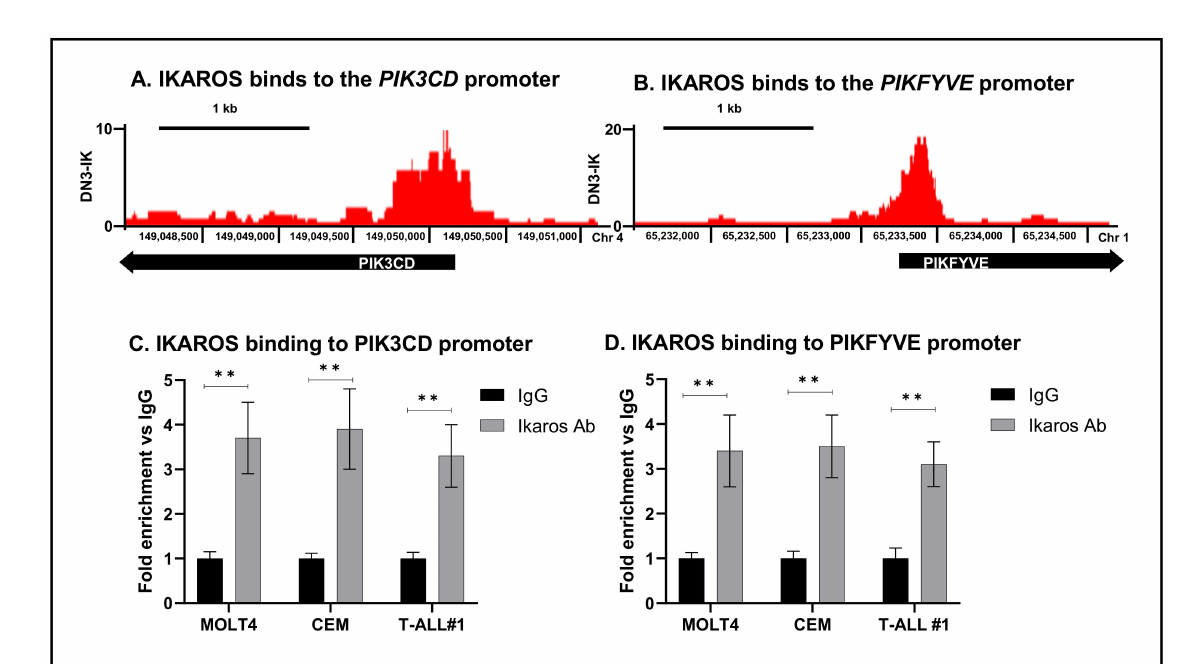
Figure 2. IKAROS binds to the promoter regions of PIK3CD and PIKFYVE . Chromatin immunoprecipitation (ChIP) followed by next-generation sequencing (ChIP-seq) and analysis of genome-wide occupancy of IKAROS was performed on DN3 cells (IKAROS-null T-ALL cells) following IKAROS re-introduction. IKAROS global DNA binding was analyzed on days 1, 2, and 3 following IKAROS introduction. ( A ) ChIP-seq signal map for IKAROS binding to the PIK3CD promoter region on day 1. ( B ) ChIP-seq signal map for IKAROS binding to the PIKFYVE promoter region on day 1. The y -axis represents a log 2 fold change enrichment of IKAROS binding (** p < 0.01). CEM, MOLT4, and T-ALL#1 cells were treated with 10 µ M of CX-4945 for 24 h. IKAROS binding to the PIK3CD ( C ) and PIKFYVE ( D ) promoter region was confirmed using qChIP assay in vehicle- and CX-4945-treated cells. Results are mean +/– SD of triplicates representative of one of three independent